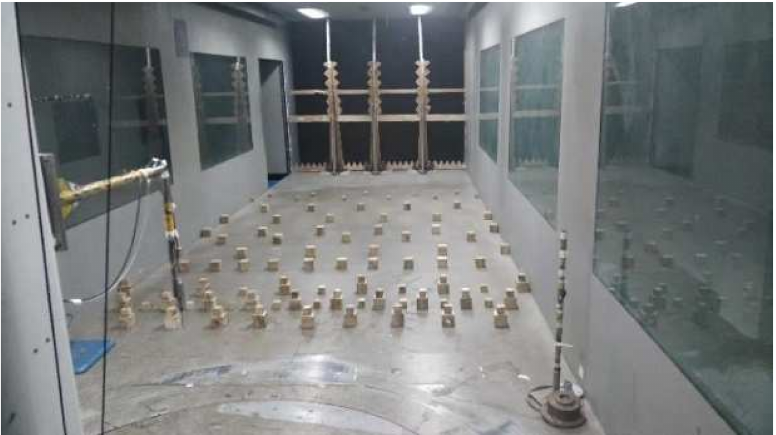
Figure 3. Simulation of type B geomorphic boundary layer in wind